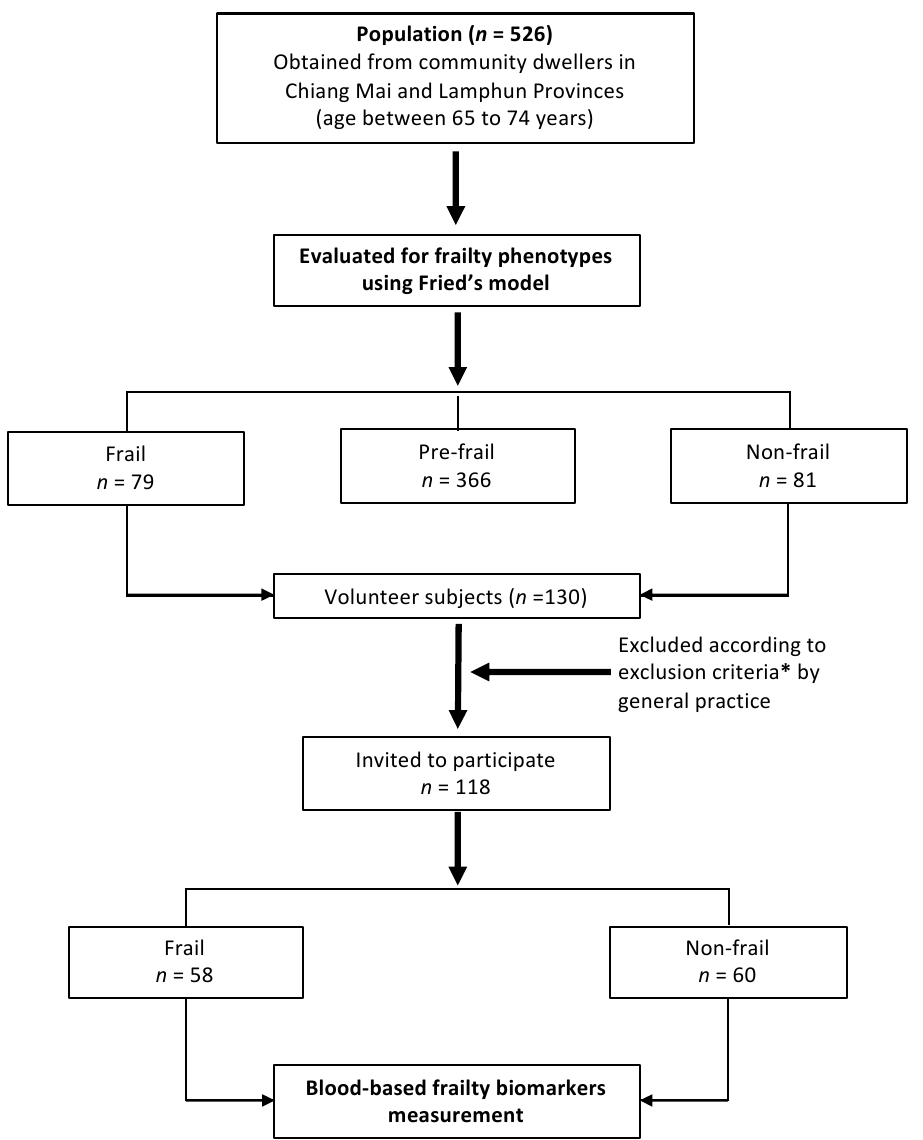
Figure 1. Diagram of sample selection in this study. * The exclusion criteria is when the participants had met either one or more of the following criteria; (i.) Severe locomotion problem (ii.) Ongoing